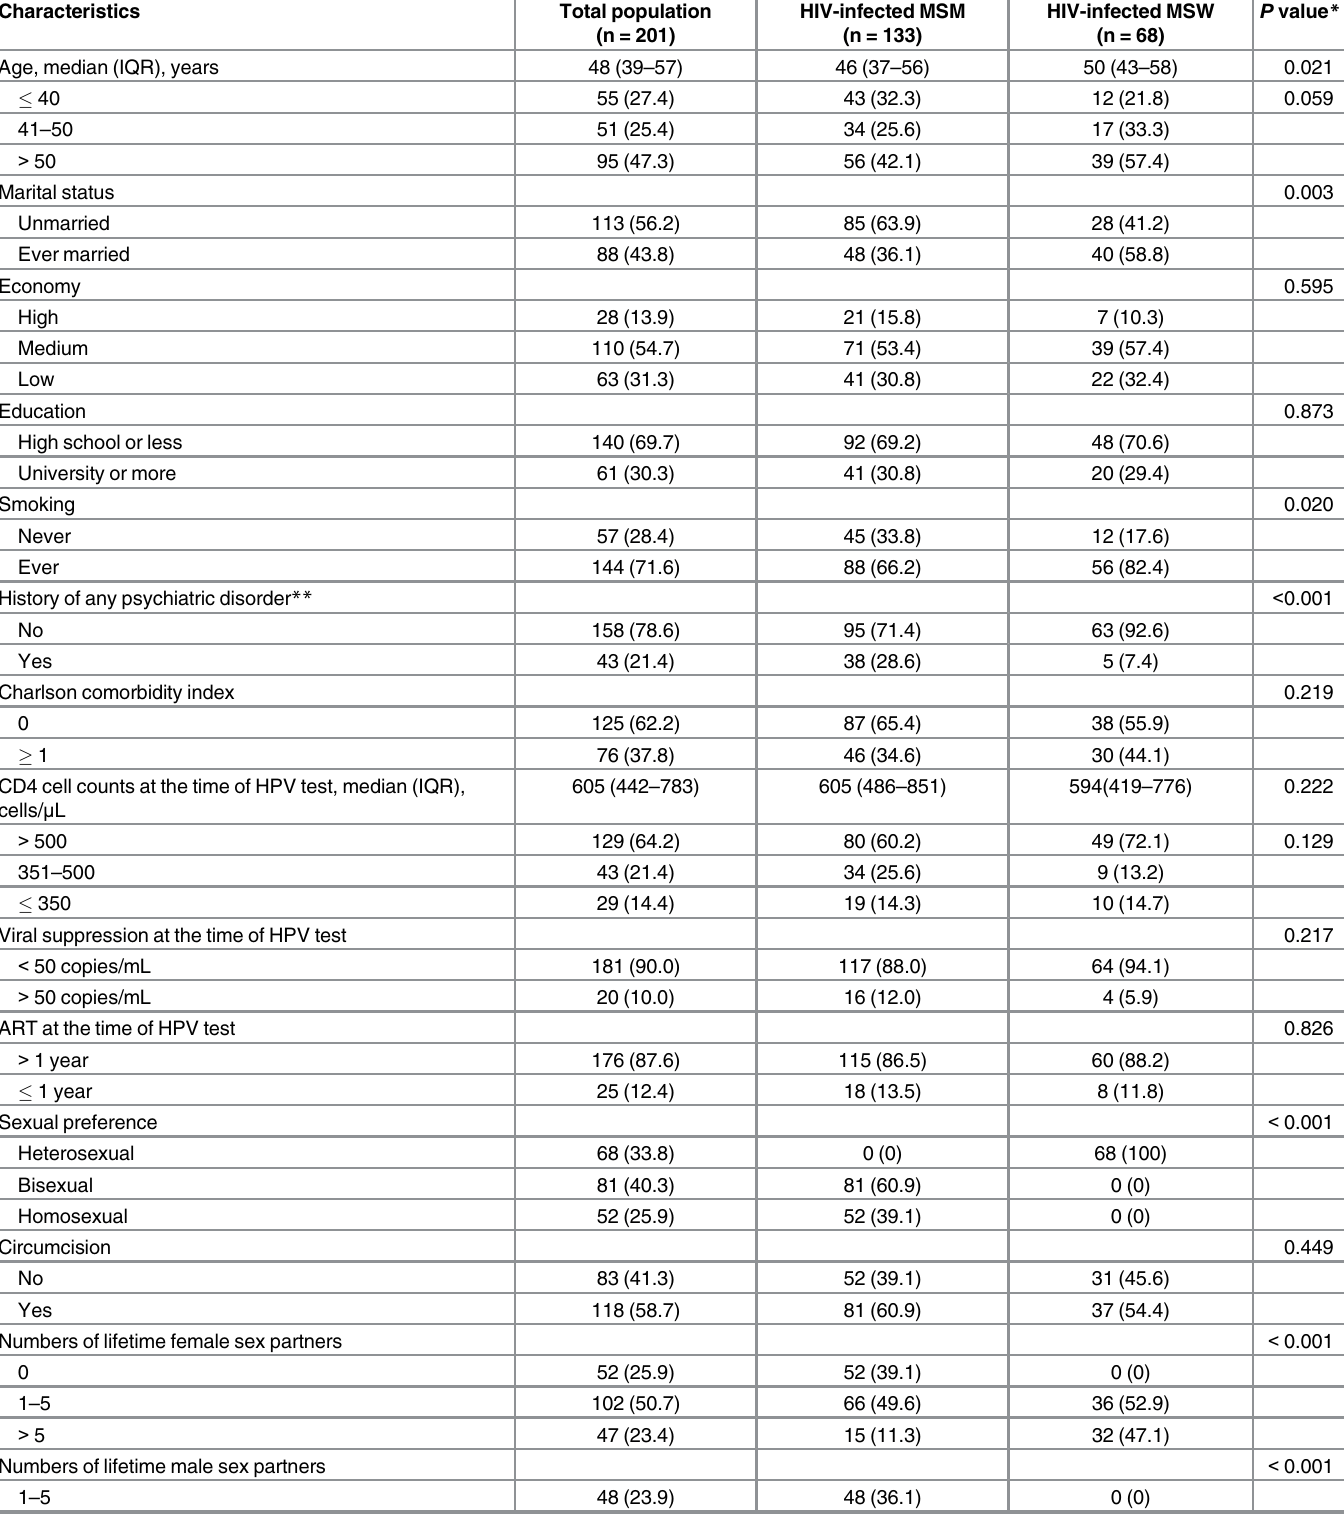
Table 1. Baseline